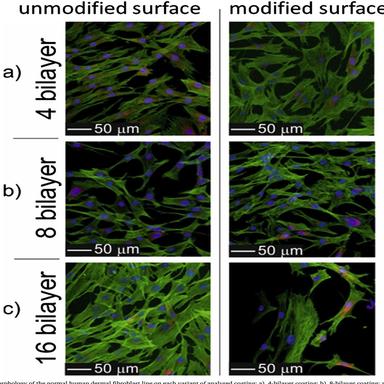
Cell morphology of the normal human dermal fibroblast line on each variant of analysed coating: a). 4-bilayer coating; b). 8-bilayer coating; and c). 16-bilayer coating.